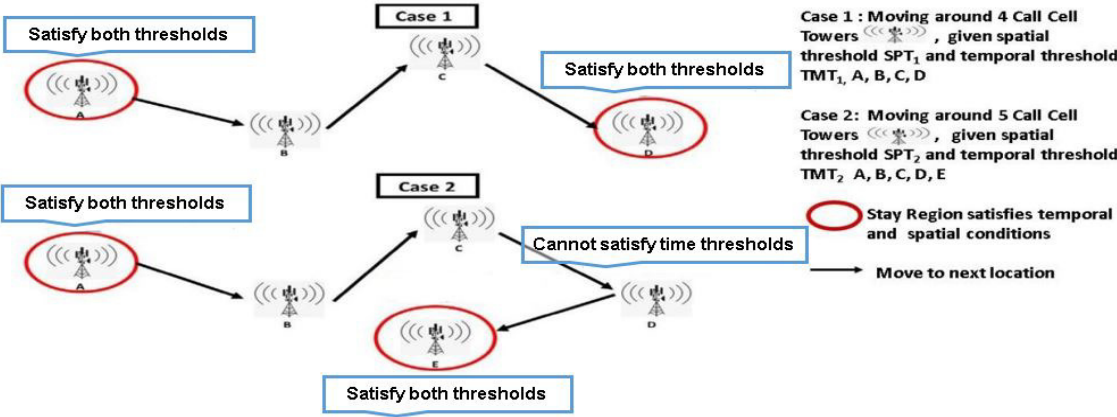
Figure 1. Two stay region